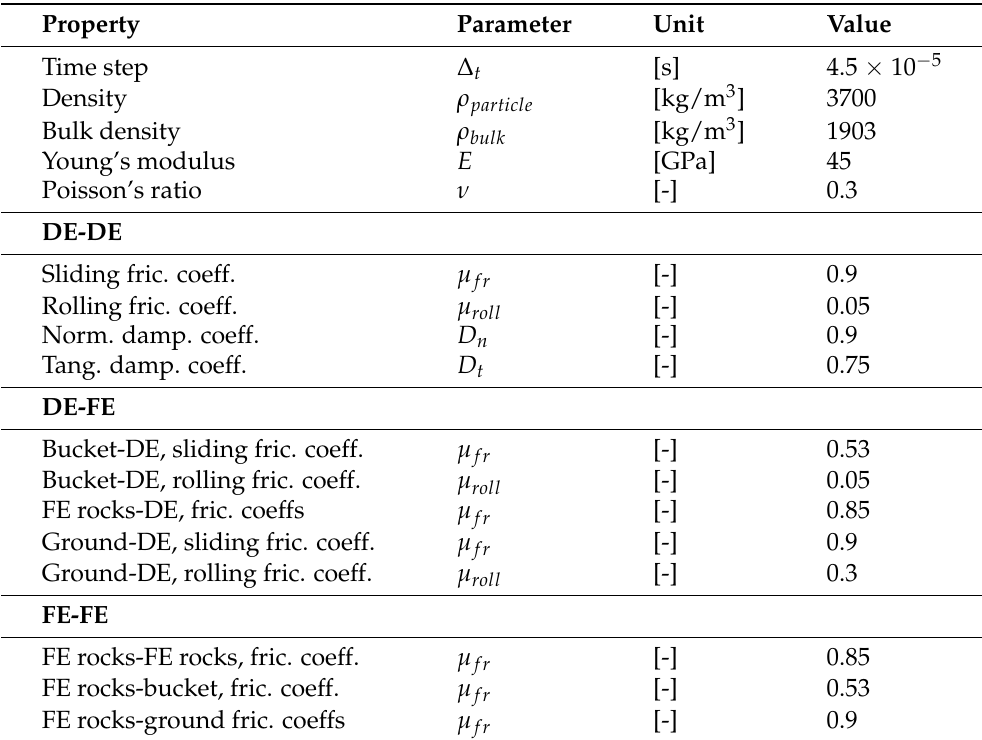
Table 1. Physical properties for the DEM granular material model. The parameters were obtained in previous work